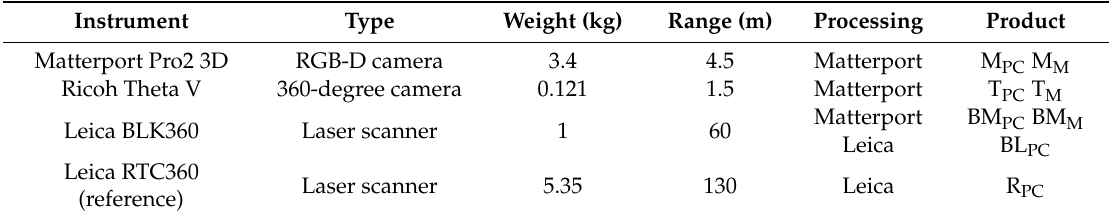
Figure 1. The test sites used for the comparisons; the Tetra hall viewed from the entrance ( left ) and hall 101 viewed towards the entrance ( right ). Table 1. Overview of the selected sensor systems used for indoor mapping and modeling.